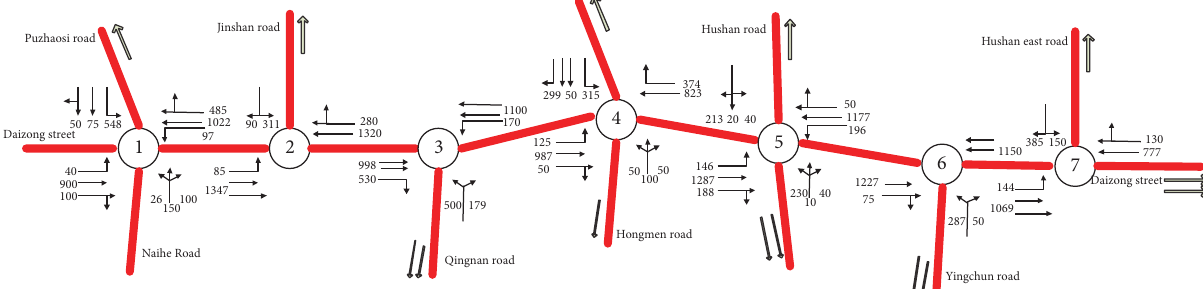
Figure 4: Traffic flow of Daizong street.